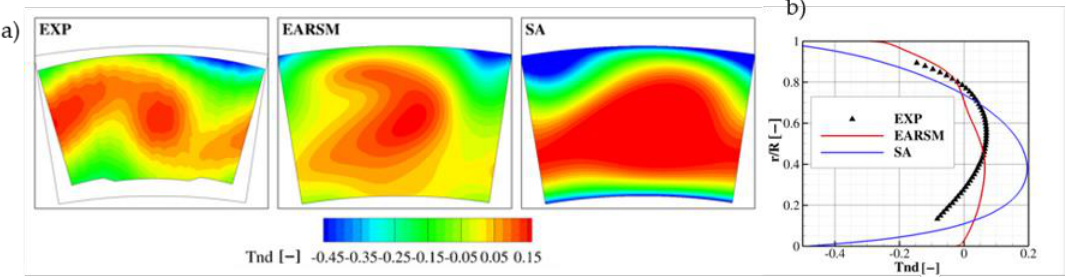
Figure 7. Non-dimensional total temperature at plane P40: 2D contour ( a ) and circumferentially averaged ( b ).